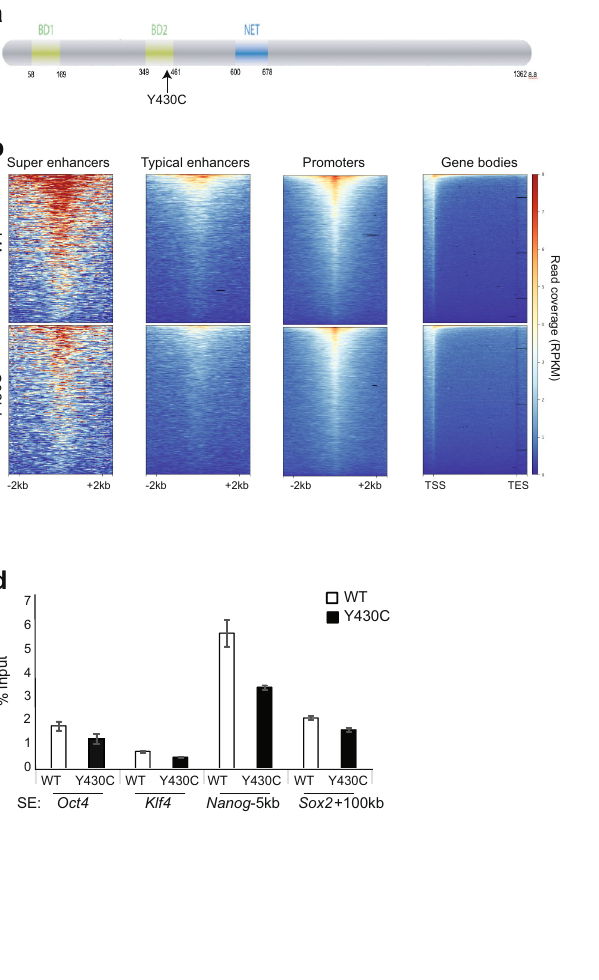
Fig. 1 Decreased binding of BRD4 at CREs in Y430C mESCs. a Cartoon of BRD4 showing location of the Y430C mutation in the second bromodomain (BD2). b Heatmaps show enrichment of wild-type (WT) and Y430C BRD4 ChIP over super enhancers (SE), typical enhancers, promoters and gene bodies. c UCSC genome browser screenshot showing reads per 10 million over the Klf4, extended Nanog and Sox2 loci for BRD4 ChIP-seq in WT and Y430C mESCs. Extent of SEs are shown in blue. Below are shown previously published ChIP-seq data for H3K27ac (ENCSR000CDE), H3K9ac (ENCSR000CGS), H3K122ac (GSE66023) and DNase I hypersensitivity (DHS). Genome co-ordinates (Mb) are from the mm9 assembly of the mouse genome. Biological replicate from an independent Y430C clone are in Supplementary Fig. 1. d ChIP-qPCR measuring concentration of BRD4 ChIP DNA relative to input across the SEs of Oct4, Klf4, Nanog, and Sox2; in WT and Y430C mESCs. Data are represented as mean ± SEM from 3 technical